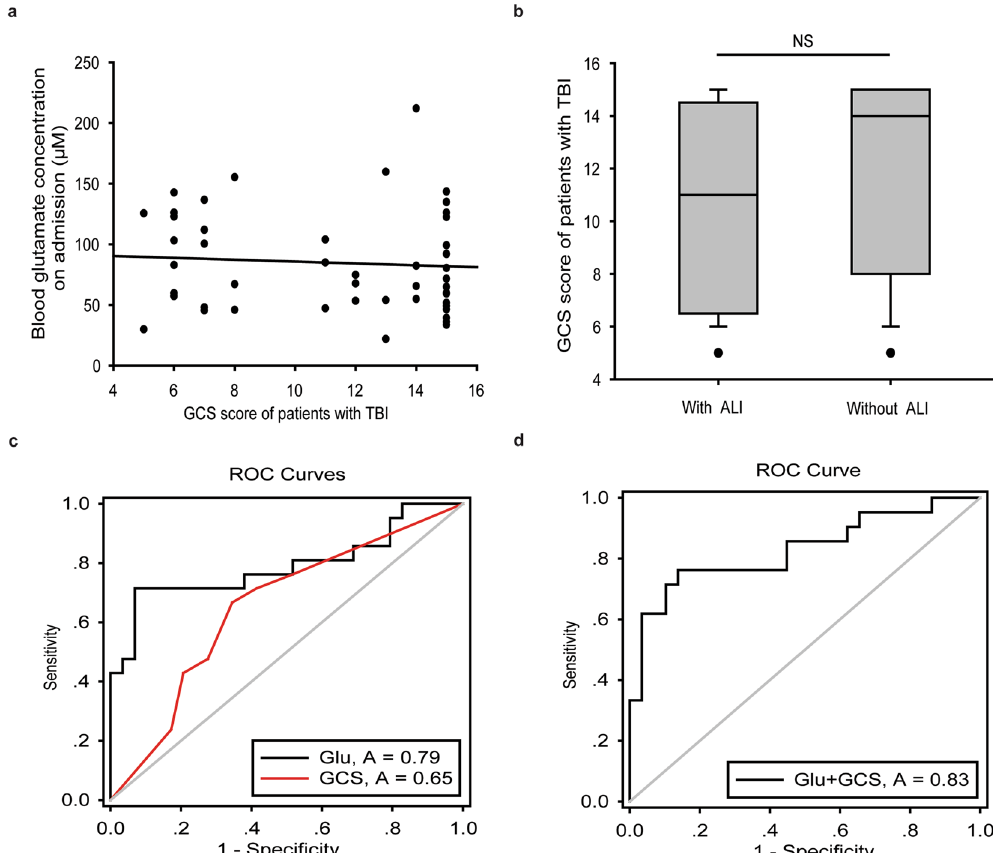
Figure 3. ( a ) There was no significant correlation between blood glutamate levels on admission and GCS score in patients with TBI ( r = 0.224, p = 0.154). ( b ) No significant difference in GCS score was observed between patients with or without TBI-ALI ( p = 0.062) using nonparametric Mann-Whitney U tests. ( c ). The AUC-ROCs showed that the predictive value of glutamate levels (AUC = 0.792; 95% CI, 0.710–0.873) was better than that of GCS score (AUC = 0.652; 95% CI, 0.565–0.739) ( p = 0.022) ( d ). ROC curve showing the logistic regression model for the combination of glutamate levels and GCS score (AUC = 0.829; 95% CI, 0.706–0.953), which was better than GCS score ( p = 0.039) but not glutamate concentration ( p = 0.243). ALI, acute lung injury; GCS, Glasgow Coma Scale; Glu, glutamate; TBI, traumatic brain